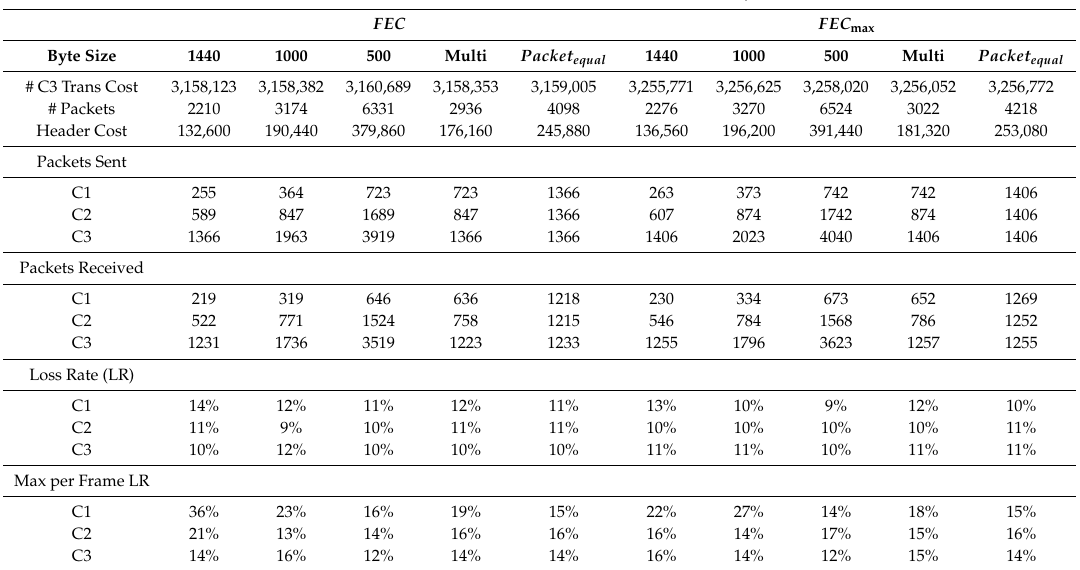
Table A8. FEC and FEC max models for all four Packet thres , as well as Packet equal . Values are illustrated for packets transmitted, additional packet header cost (60 bytes per packet) and individual packets sent, packets received, loss rate per class and maximum loss rate per frame for SVC-SC, for an overall packet loss rate of 10% and a GOP of 32.